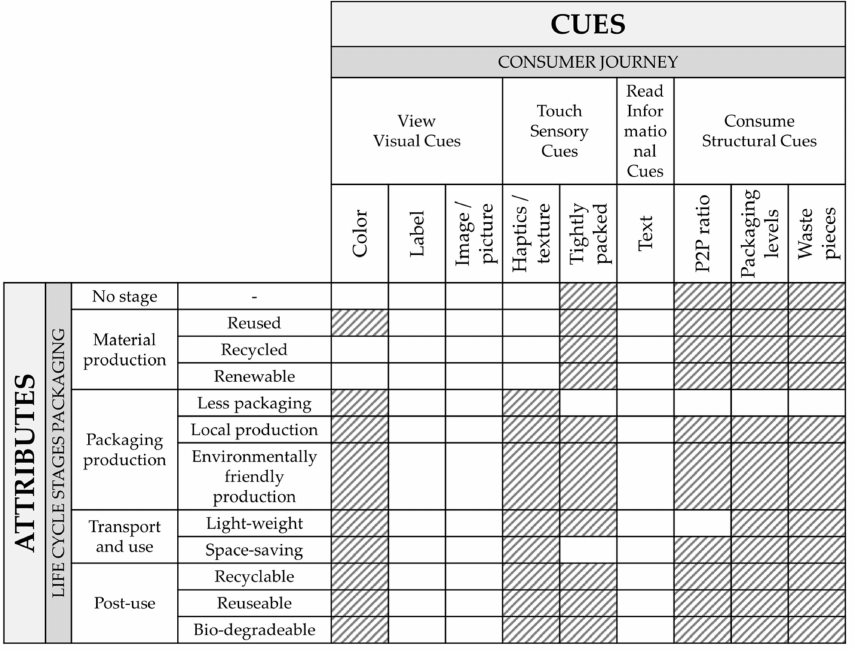
Figure 1. Attribute–cue matrix. Abbreviation: P2P ratio (product-to-packaging